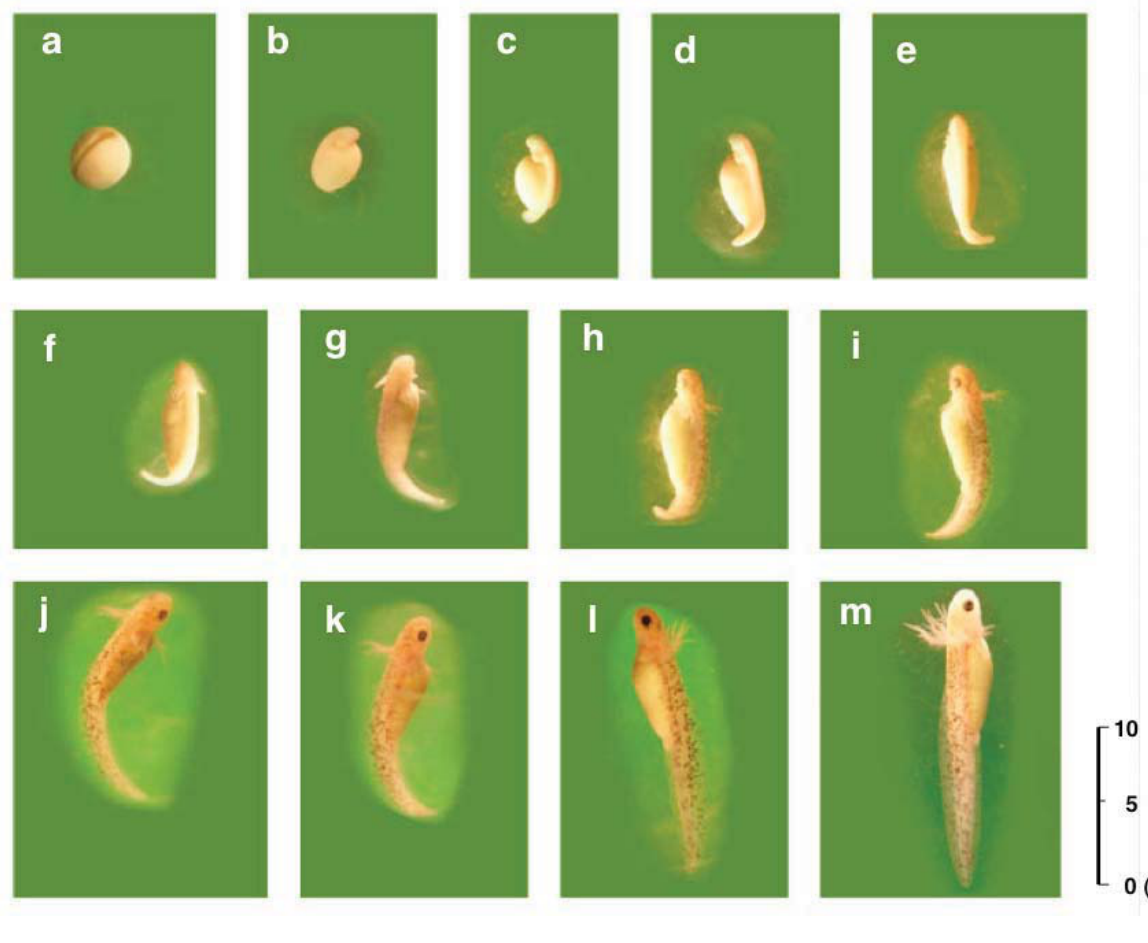
Figure 6. Normal development from the neurula to hatching stages: ( a ) 8-day-old neurula embryo, ( b ) 9-day-old tailbud embryo, ( c ) 10-day-old larva, ( d ) 11-day-old larva, ( e ) 12-day-old larva, ( f ) 13-day-old larva, ( g ) 14-day-old larva, ( h ) 15-day-old larva, ( i ) 16-day-old larva, ( j ) 17-day-old larva, ( k ) 18-day-old larva, ( l ) 19-day-old larva, ( m ) 20-day-old hatched